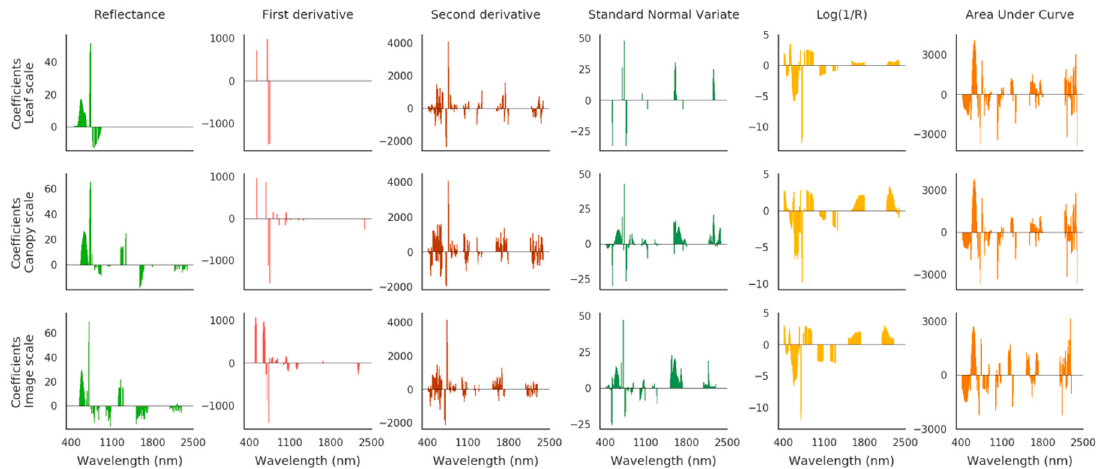
Figure 5. Coefficients obtained by the elastic net (ENET) method on the 10 plots of the brownfield using the original and transformed spectral signatures (in columns). First, second, and third rows show the results obtained at leaf and canopy scales and on the airborne image, respectively. The spectral bands contributing to TPH predictions are denoted by nonzero coefficients.